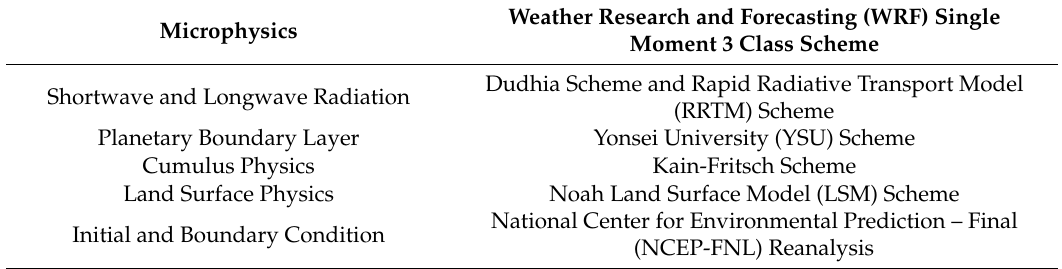
Table 1. Physics schemes used in this